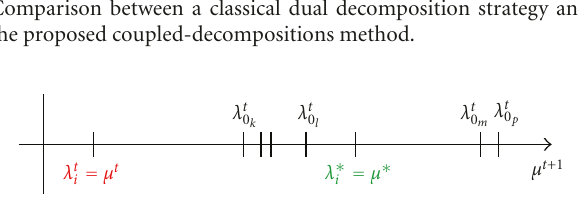
Figure 9: Example of the situation before dual